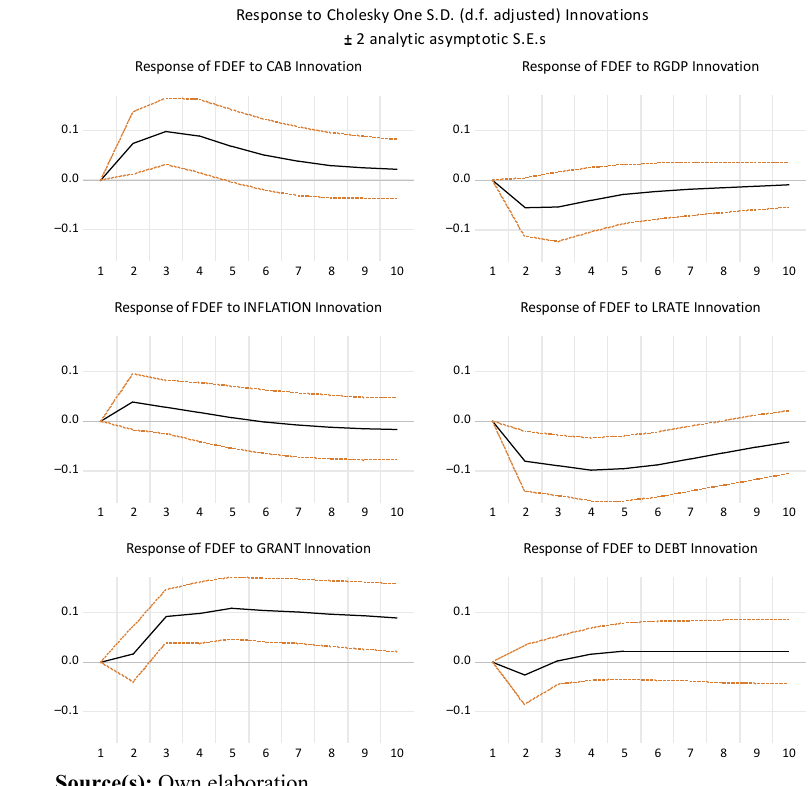
Figure 1. Impulse response